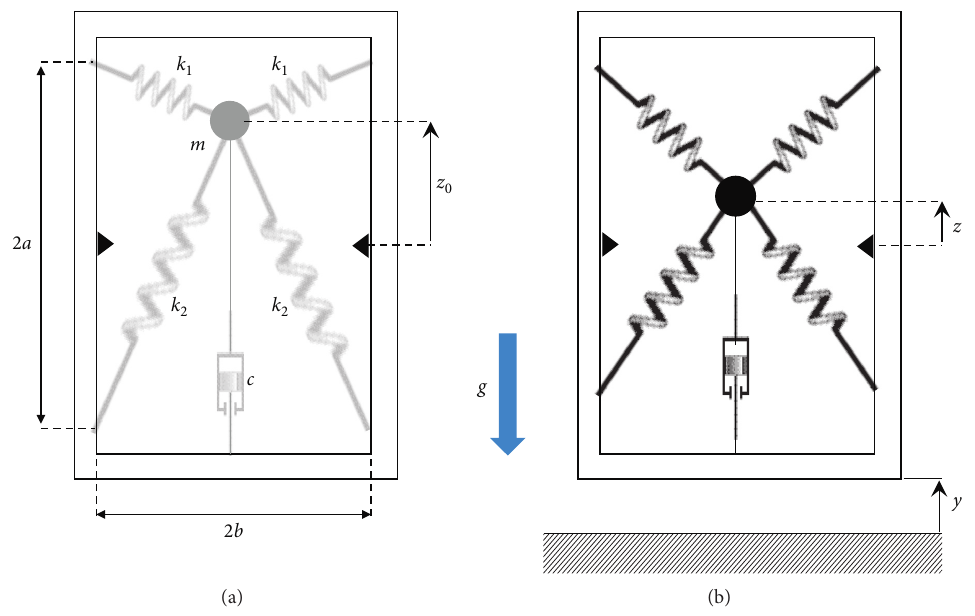
Figure 1: Schematic of the X -shaped suspension: (a) configuration upon assembly with no gravity effect; (b) generic deformed configuration subject to